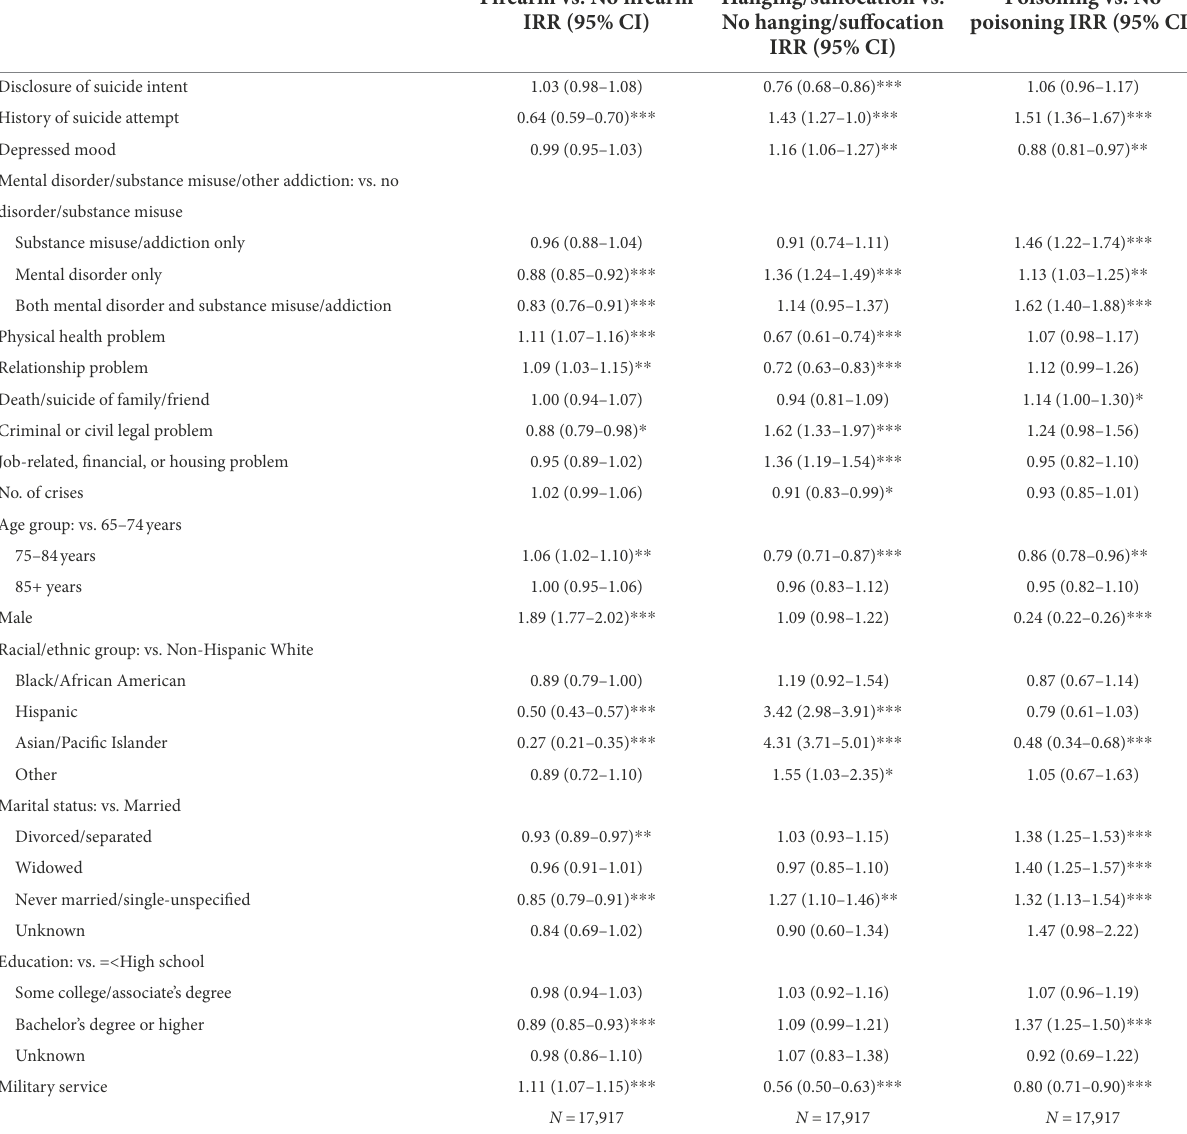
TABLE 5 Association between intent disclosure and suicide means: Results from generalized linear models with Poisson and log